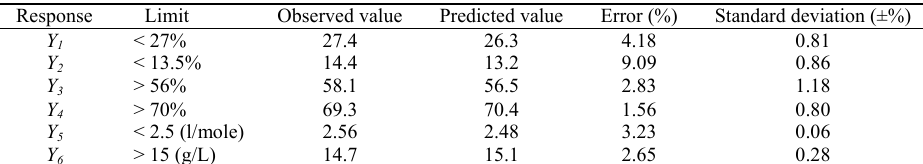
Table 6: Verification experiment in the joint simultaneous optimized conditions Response